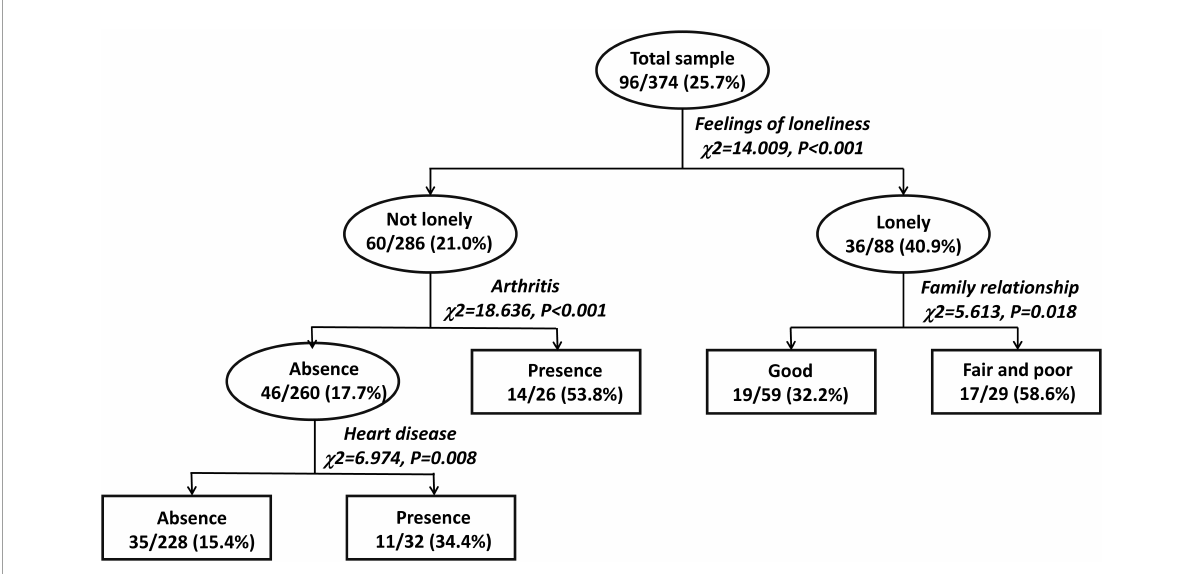
FIGURE1 Classification tree analysis for major correlates of depressive disorders and the interactions of factors in older Chinese adults with hypertension.